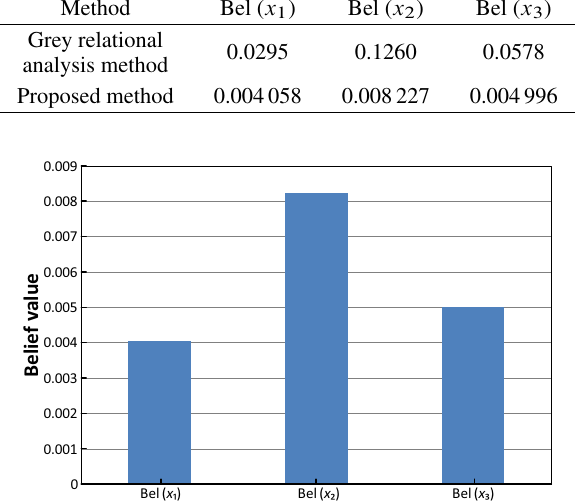
Fig. 3 Belief values of alternatives for the proposed